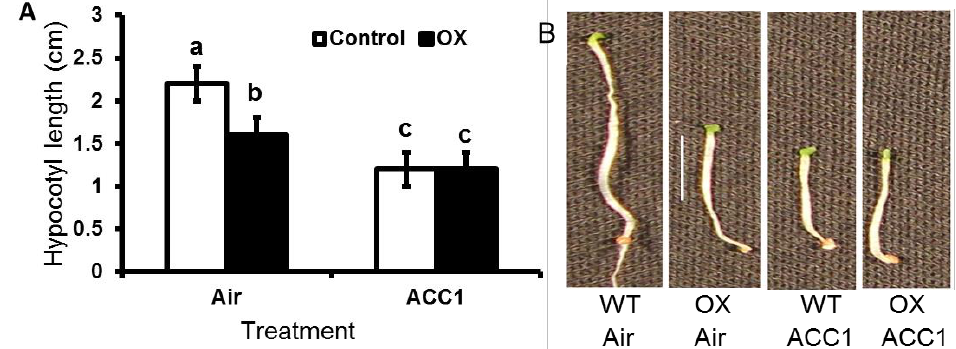
Figure 7. A comparison of triple response in control and PI3K overexpressing tobacco seedlings (OX). Seeds were germinated and grown for 10 days in 0 µM (air) and in 1 µM ACC (1-aminocyclopropane-1-carboxylic acid). ( A ) Hypocotyl length of tobacco seedlings after 10 days of treatment. Data represent mean ± standard error for a total of n = 7–10 seedlings from three biological replicates. ANOVA was performed on data and significant ( p < 0.05) differences between means were determined using Duncan test. Statistical significance among means is denoted by different letters (a–c); ( B ) Appearance of seedlings subjected to different treatments after 10 days. Scale represent 1 cm.